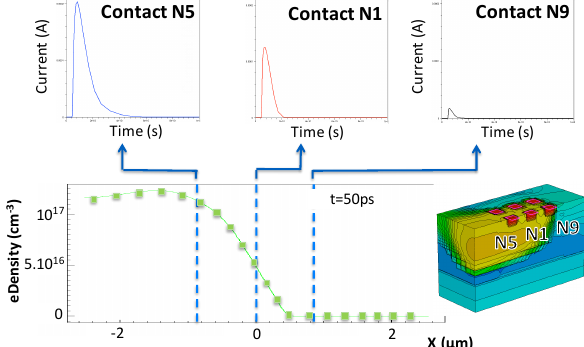
Fig. 5. Example of variation of the current at the output of three pixels related to the electron density, for an alpha particle generated horizontally.